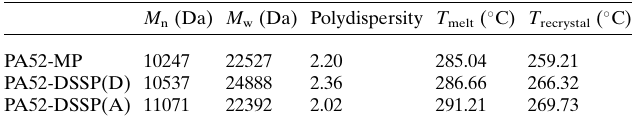
Table 3 Comparison of the molecular weight and thermodynamic properties for PA 52 by MP and DSSP